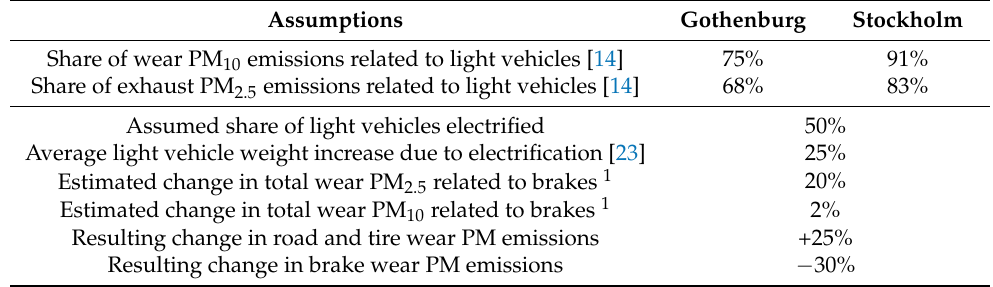
Table 4. Assumptions and estimations made to calculate change in emissions for a scenario with 50% electrification of light